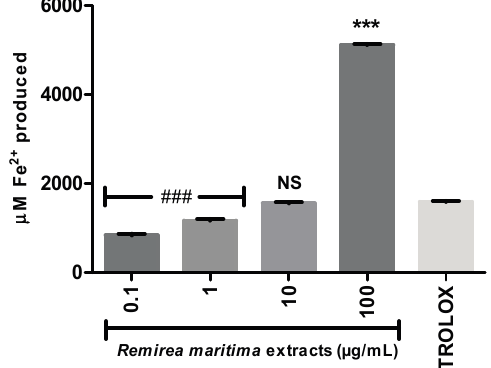
Figure 3. Ferric Reducing Antioxidant Power (FRAP). Trolox ® (75 µg/mL) was used as standard antioxidant. ### less efficiency than Trolox ® ( p < 0.0001); NS Non-significant compared to Trolox ® ; *** higher efficiency than Trolox ® ( p < 0.0001) (1-way ANOVA followed by Tukey’s multiple comparison post hoc test); bars represent mean ±